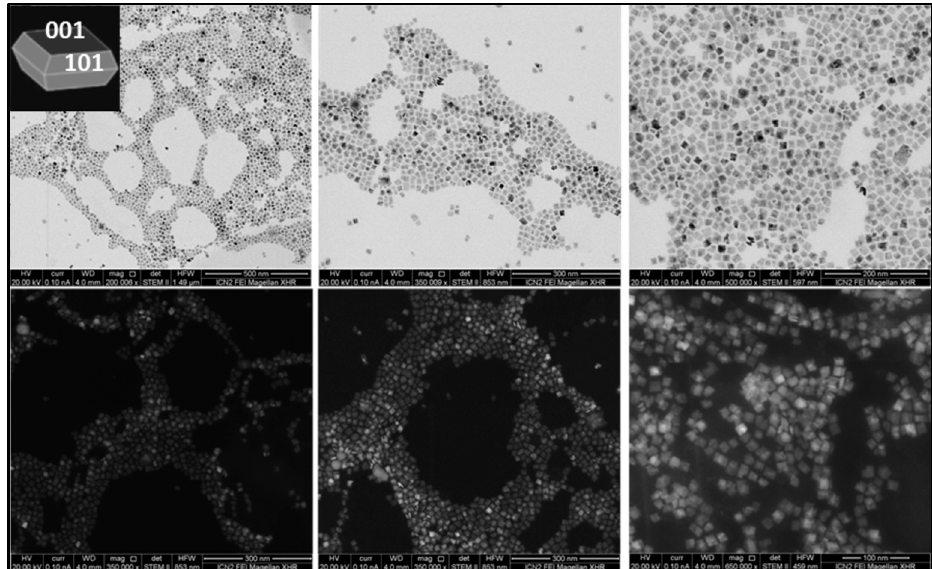
Figure 3. TiO 2 plates. STEM images of TiO 2 NPs synthesized using TiF 4 /TiCl 4 as precursors in the presence of 1-ODOL. The use of the mixed TiF 4 /TiCl 4 precursor in combination with 1-ODOL forms plates (50 nm side length, 10 nm width).